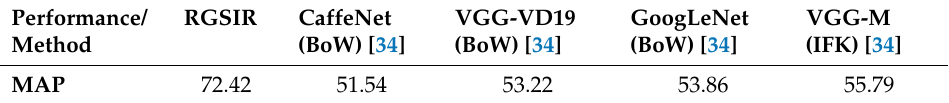
Table 6. Comparison of the mean average precision when using RSSCN image benchmark.